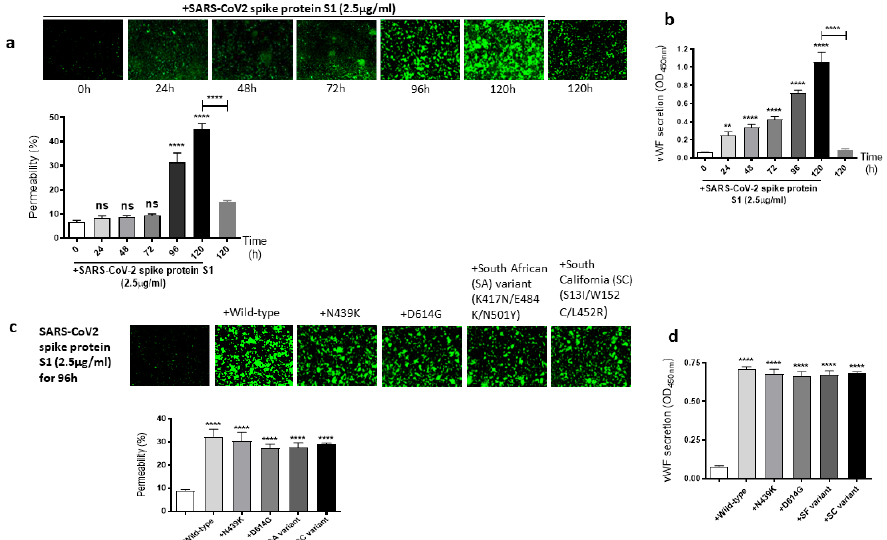
Figure 3. Effect of the SARS-CoV-2 spike protein S1 and its mutants on EA.hy 296 cell monolayer per- meability and its vWF secretion. ( a ) Visualization at 10 × magnification of SARS-CoV-2 spike protein S1-induced permeability in a time-dependent manner in EA.hy 296 cells monolayers. ( lower panel ) Represents the quantification data of ( a ). ( b ) vWF secretion by EA.hy 296 cell monolayer treated with 2.5 µ g/mL spike protein S1 for 0–120 h. ( c ) Visualization at 10 × magnification of permeability of EA.hy 296 cell monolayer treated without or with 2.5 µ g/mL of the SARS-CoV-2 spike protein S1 (WT) or its mutants for 96 h. ( lower panel ) Represents the quantification data of ( c ). ( d ) vWF secretion by EA.hy 296 cell monolayers treated with 2.5 µ g/mL spike protein S1 or its mutants for 96 h. Statistical significance was measured by two-way ANOVA comparing the treated with the untreated control (** p < 0.01, **** p < 0.0001. ns, not